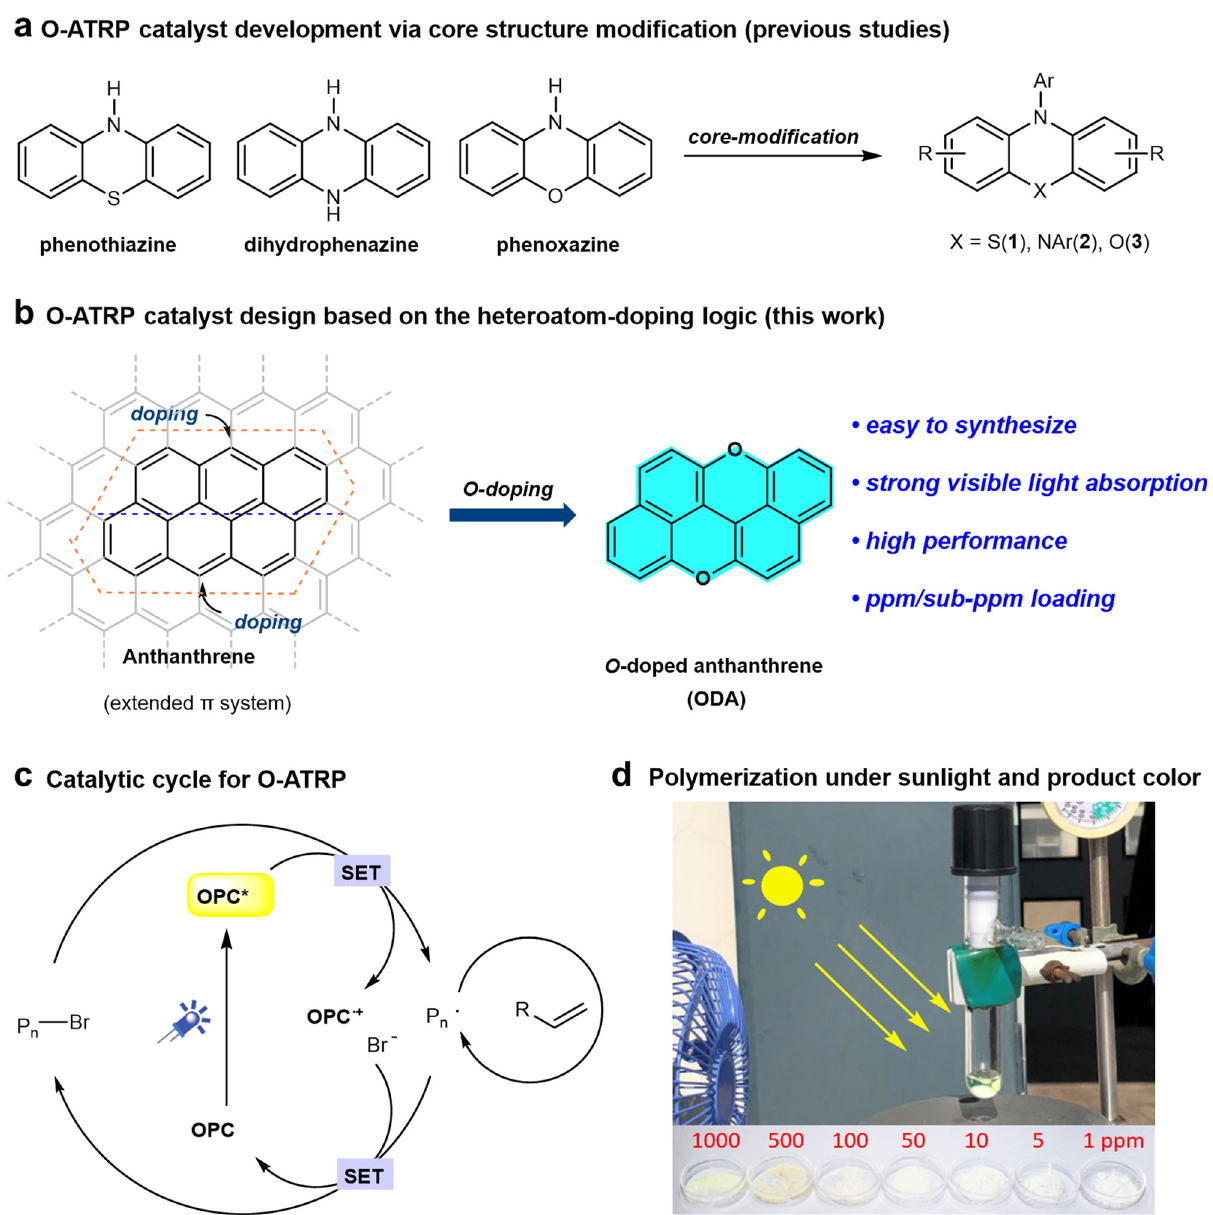
Fig. 1 The development of catalysts for O-ATRP. a Catalyst development via core structure modi fi cation. b O-ATRP photocatalyst design based on a heteroatom-doping logic (this work). c Catalytic cycle for a light-mediated O-ATRP. d Polymerization under sunlight and the product color (PMMA). SET single electron transfer, OPC organic photocatalyst, PMMA polymethyl